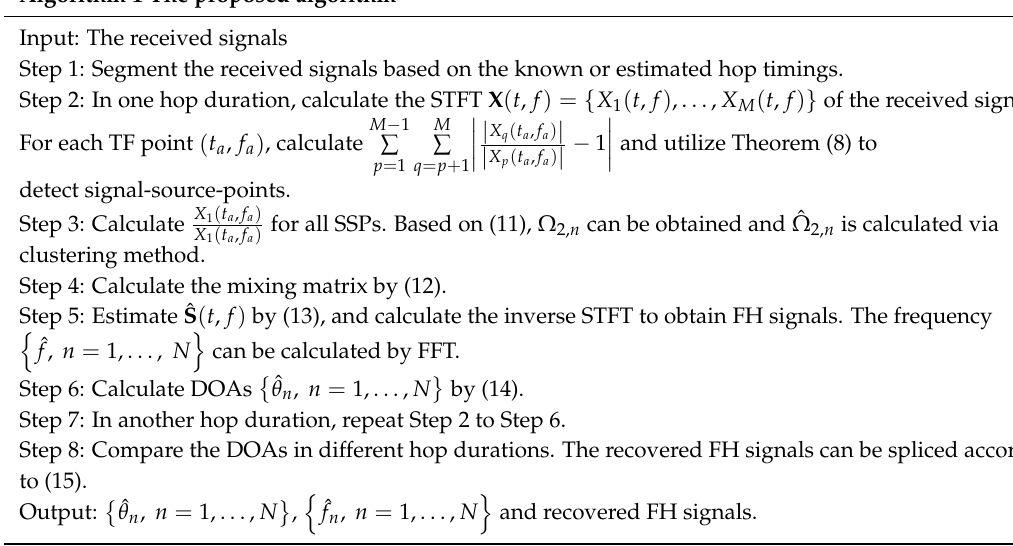
Algorithm 1 The proposed algorithm